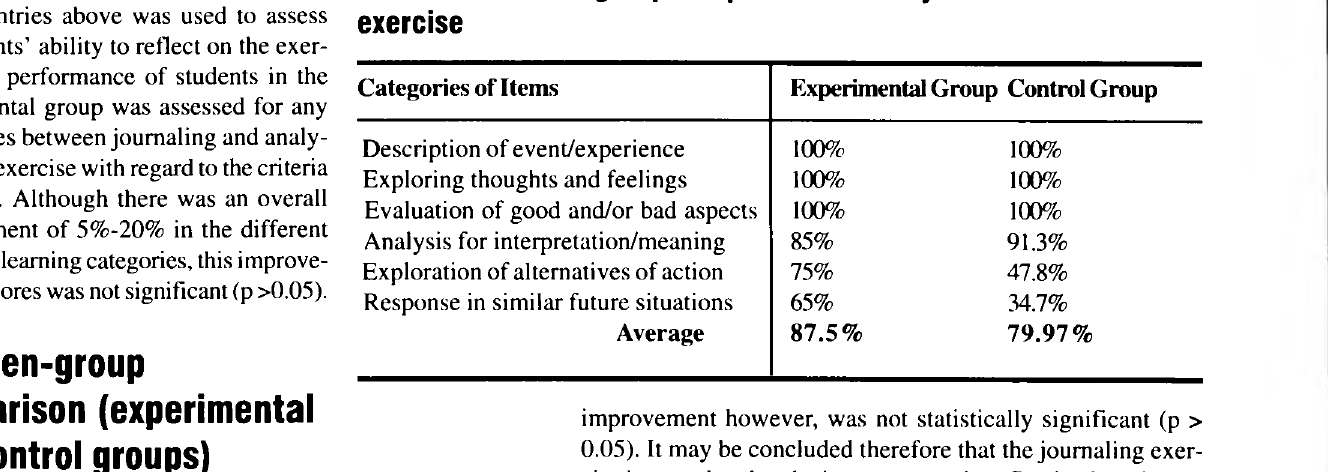
TAB LE 3: Between-group comparison on analysis of